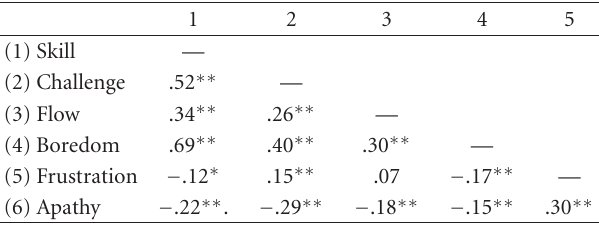
Table 2: Correlations between study